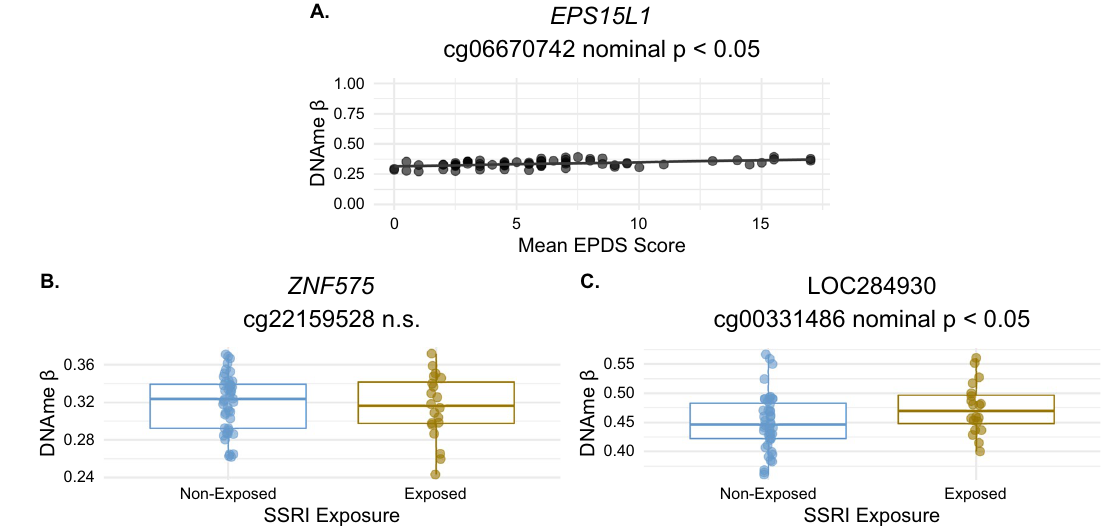
Figure 4. Assessment of literature candidates for SSRI and depression-associated DNAme in the discovery cohort. ( A ) Scatterplot showing the association between DNAme and maternal Edinburgh Postnatal Depression Score (EPDS) at cg06670742 which was previously found to be differentially methylated in association with maternal EPDS score in Tesfaye et al. 37 and is differentially methylated by SSRI exposure at FDR < 0.05 in our discovery cohort. DNAme β value at this CpG is plotted along the Y axis, mean maternal EPDS score is plotted along the X axis and each point is a case; Δβ per unit increase in EPDS is Δβ = + 0.003. ( B ) Boxplot showing mean DNAme β value ± one standard deviation by SSRI exposure status at cg22159628 in ZNF575 , previously found to be differentially methylated in cord blood with antidepressant exposure. Linear modelling p value = 0.67, points are colored by SSRI exposure (blue = SSRI non-exposed, dark yellow = SSRI-exposed), n.s. = not significant. (C) Boxplot showing mean DNAme β value ± one standard deviation by SSRI exposure status at cg00331486 in LOC284930 on chromosome 22, previously found to be differentially methylated in cord blood by SSRI exposure